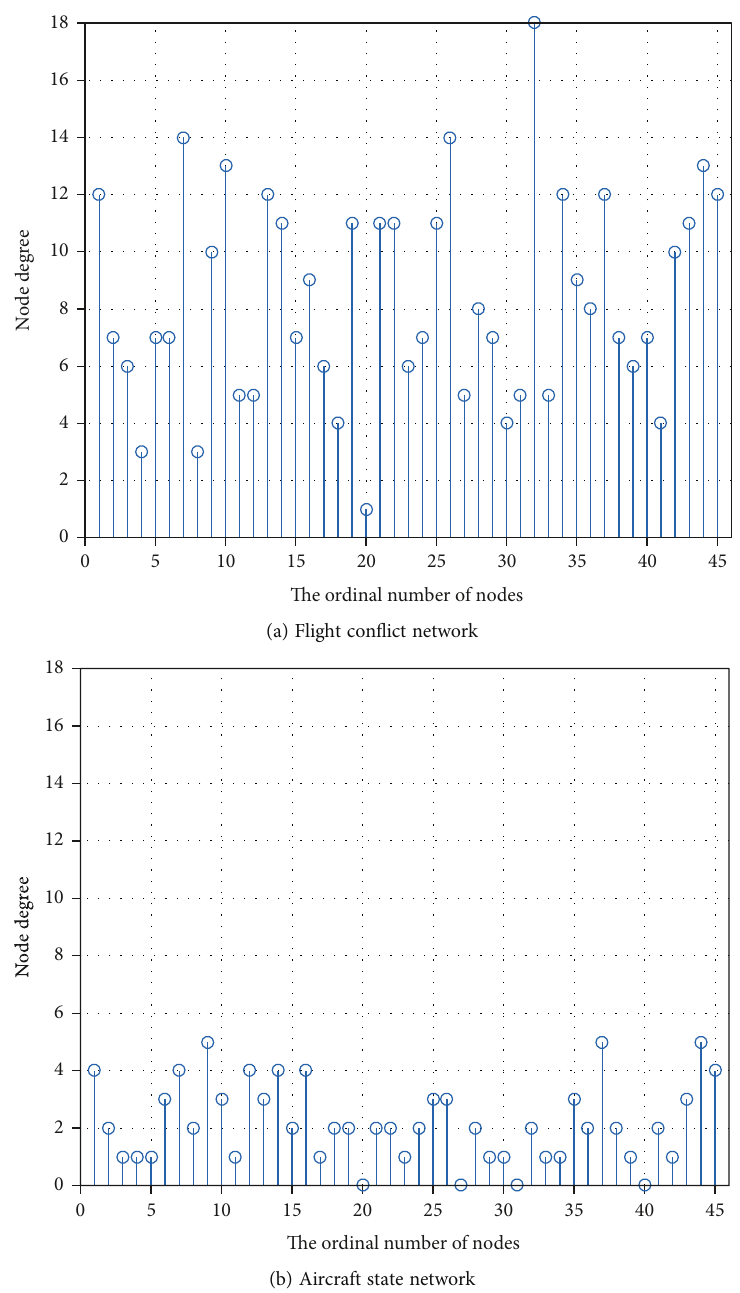
Figure 13: Node degree comparison of the